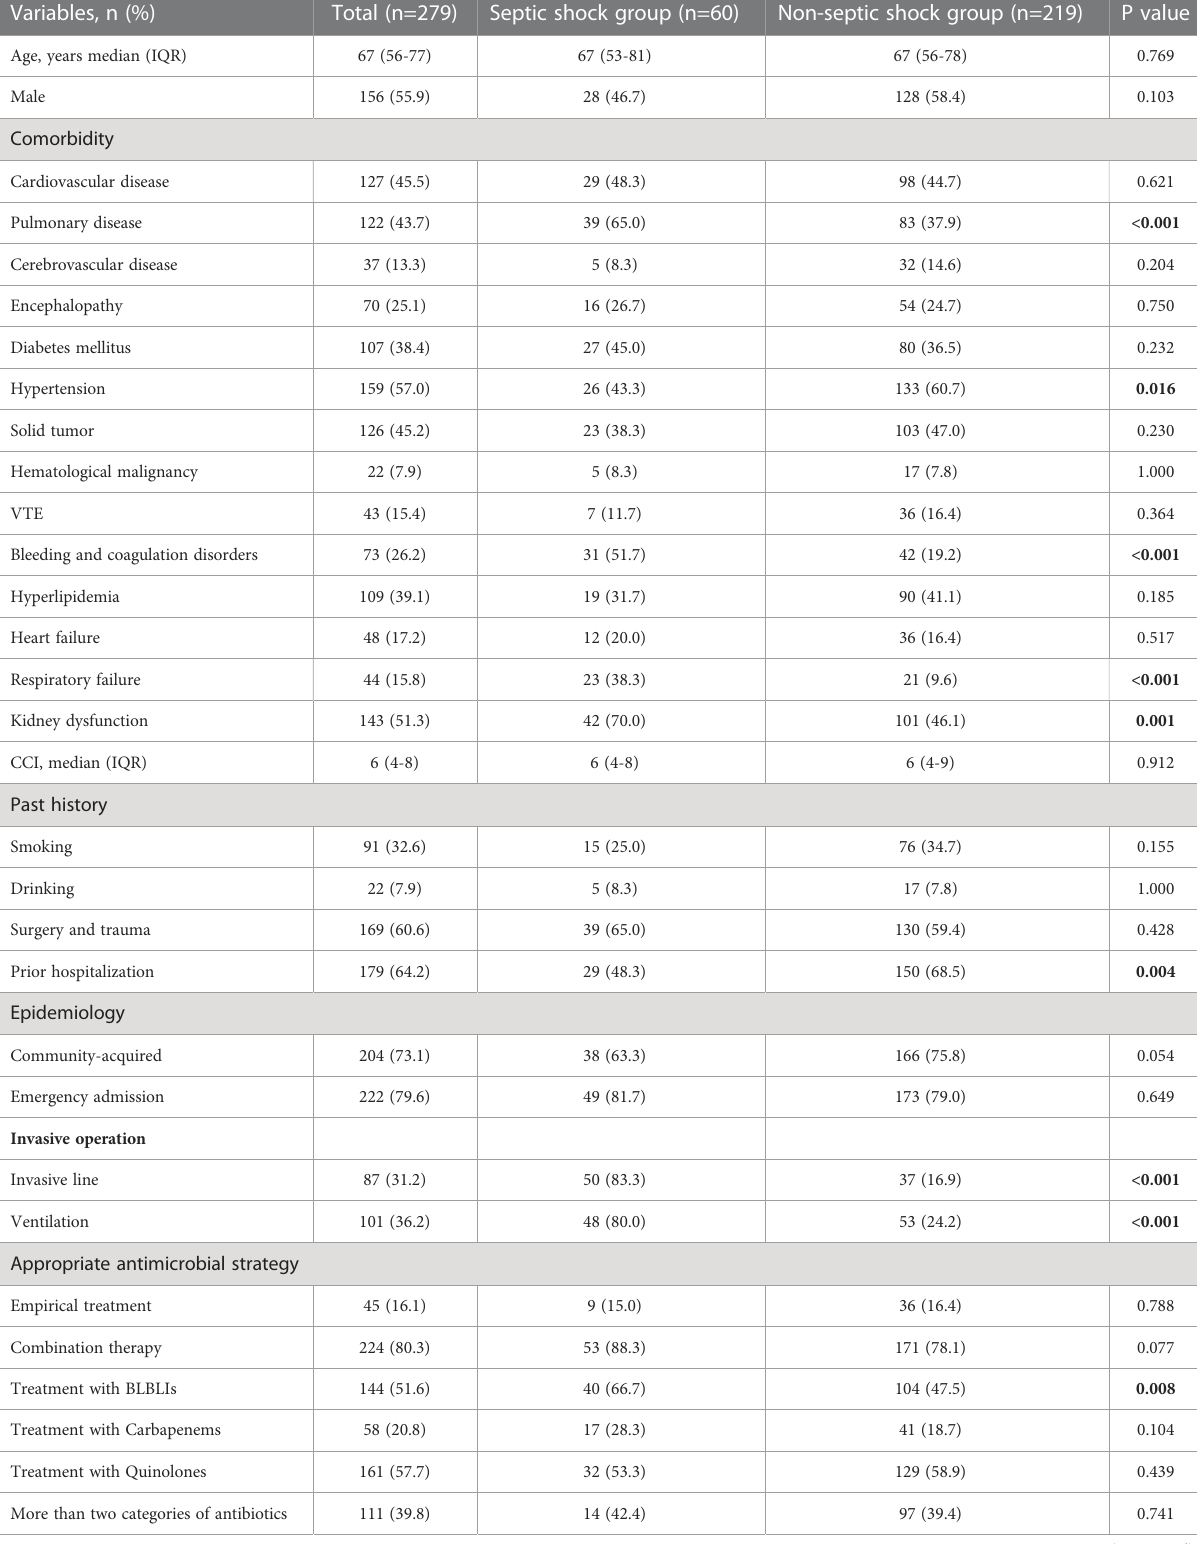
TABLE 3 The demographic and clinical characteristics in septic shock and non-septic shock of 279 patients with